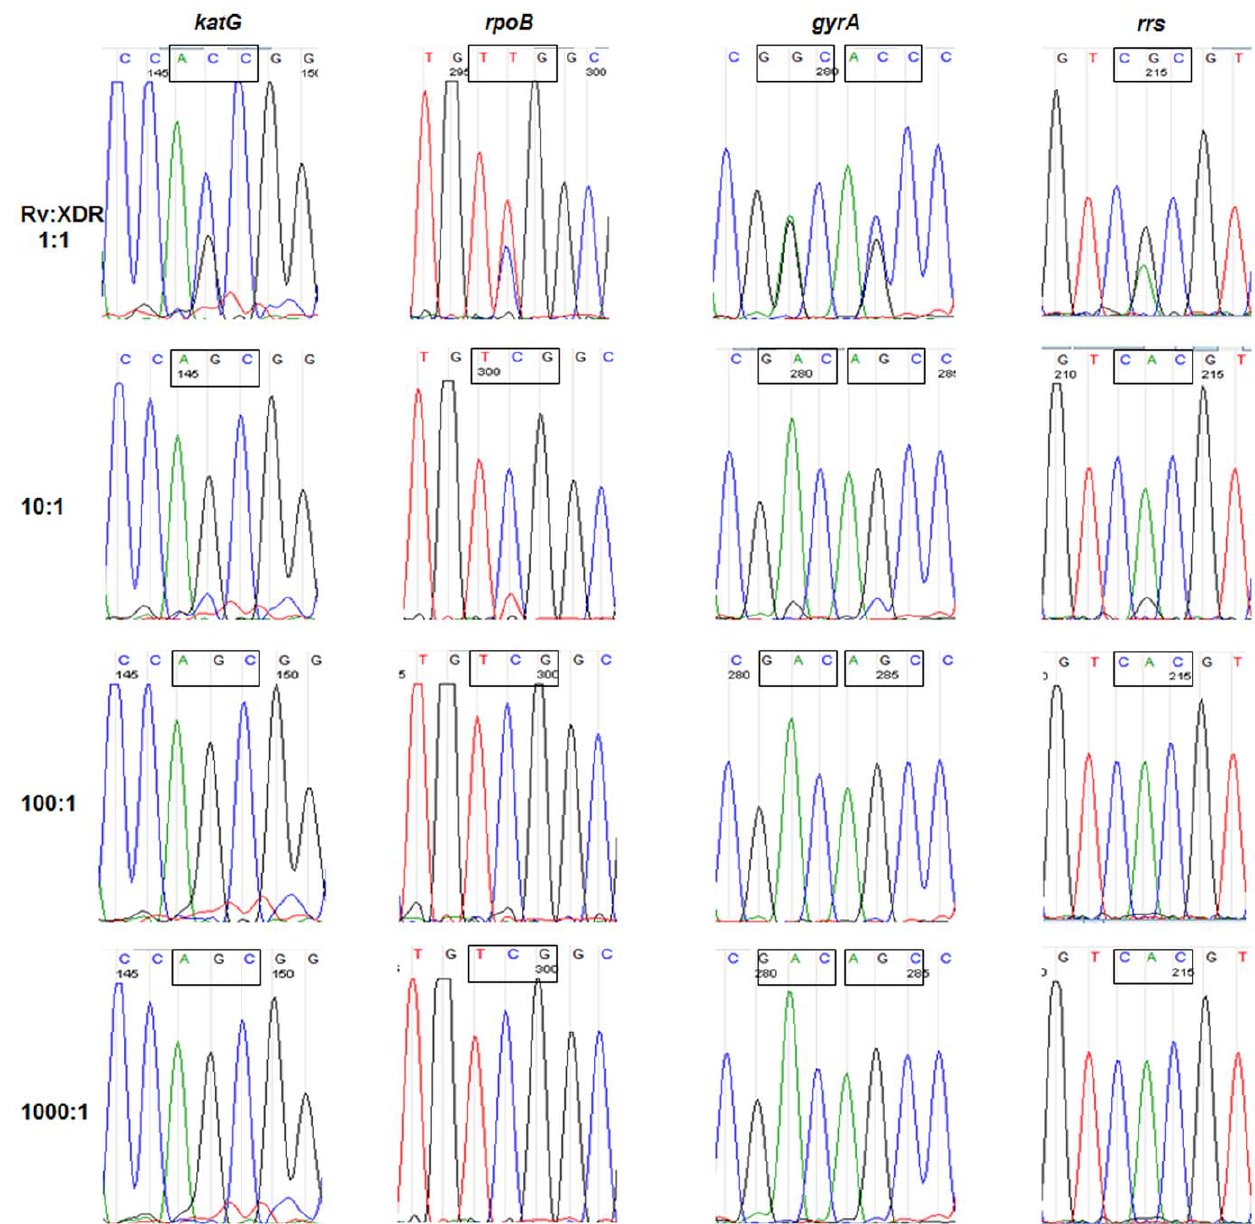
Figure 3. Sanger sequencing of the H37Rv:XDR-TB mixtures. Undiluted DNA underwent PCR and purified products were sequenced. Mixtures of 10:1, 100:1, and 1000:1 were reported as wild-type per the sequencing instrument.